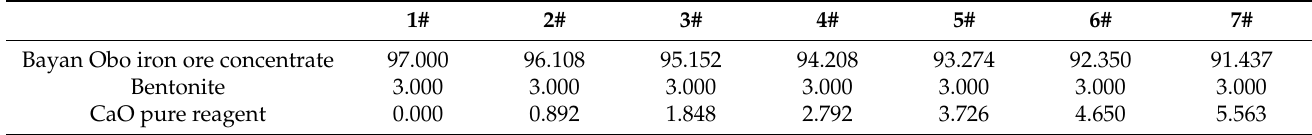
Table 2. The rate of various materials of pellets with different